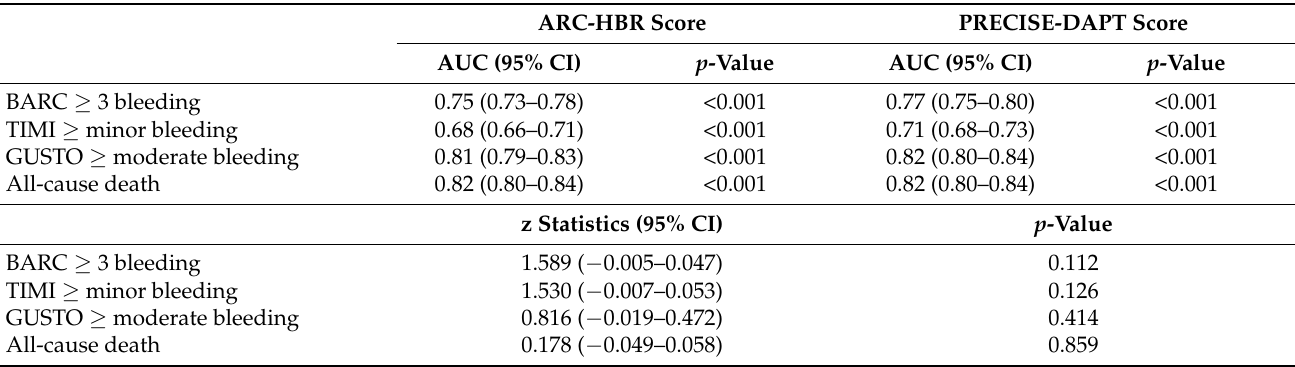
Figure 3. Distribution of risk categories for the PRECISE-DAPT score according to different ARC-HBR scores. ARC-HBR, Academic Research Consortium for High Bleeding Risk criteria; PRECISE-DAPT, Predicting Bleeding Complication in Patients Undergoing Stent Implantation and Subsequent Dual Antiplatelet therapy. Table 5. Discriminative power of the ARC-HBR score and PRECISE-DAPT score for predicting 1-year bleeding according to definition.